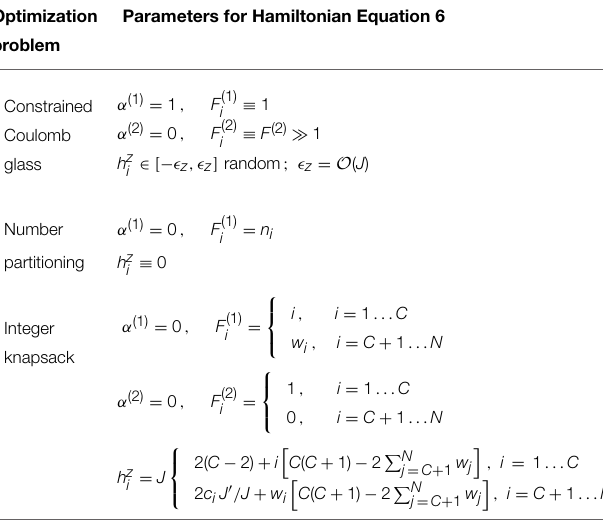
TABLE 1 | NP-complete problems encodable via Hamiltonian Equation